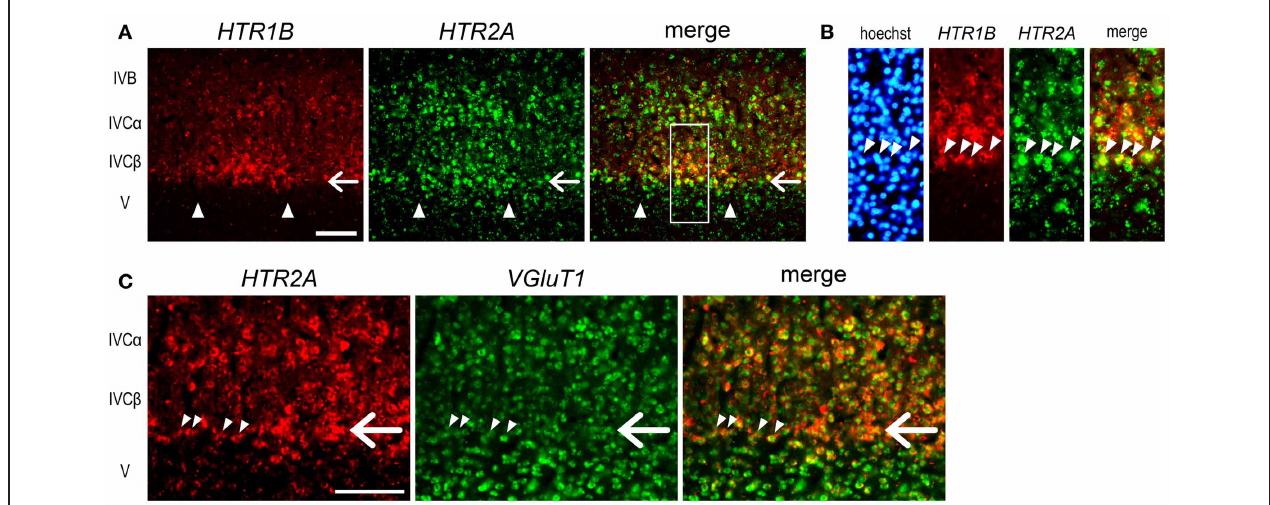
FIGURE 4 | Double ISH of HTR1B and HTR2A in V1 of monocularly stimulated marmosets. (A) Double ISH of HTR1B (red) and HTR2A (green) mRNAs 240min after visual stimulation. HTR1B and HTR2A mRNAs were coexpressed in most of the same neurons in active-eye columns of layer IVC in V1. White arrows indicate the sublayer where HTR2A mRNA was constantly expressed regardless retinal activity. This is the same sublayer which is indicated by a filled asterisk in Figure 3J . Arrowheads indicate the boundaries of ODCs. (B) Magnified images of the region indicated by open